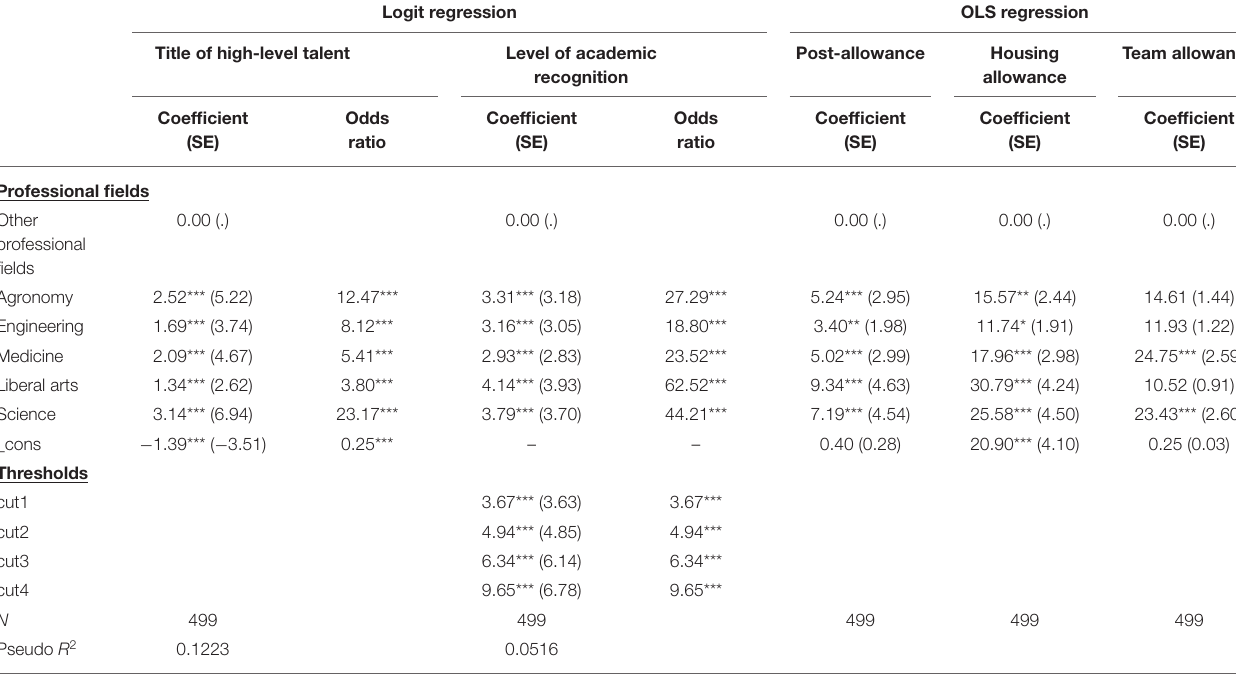
TABLE 6 | The impact of different professional fields on talent selection and funding. Logit regression OLS